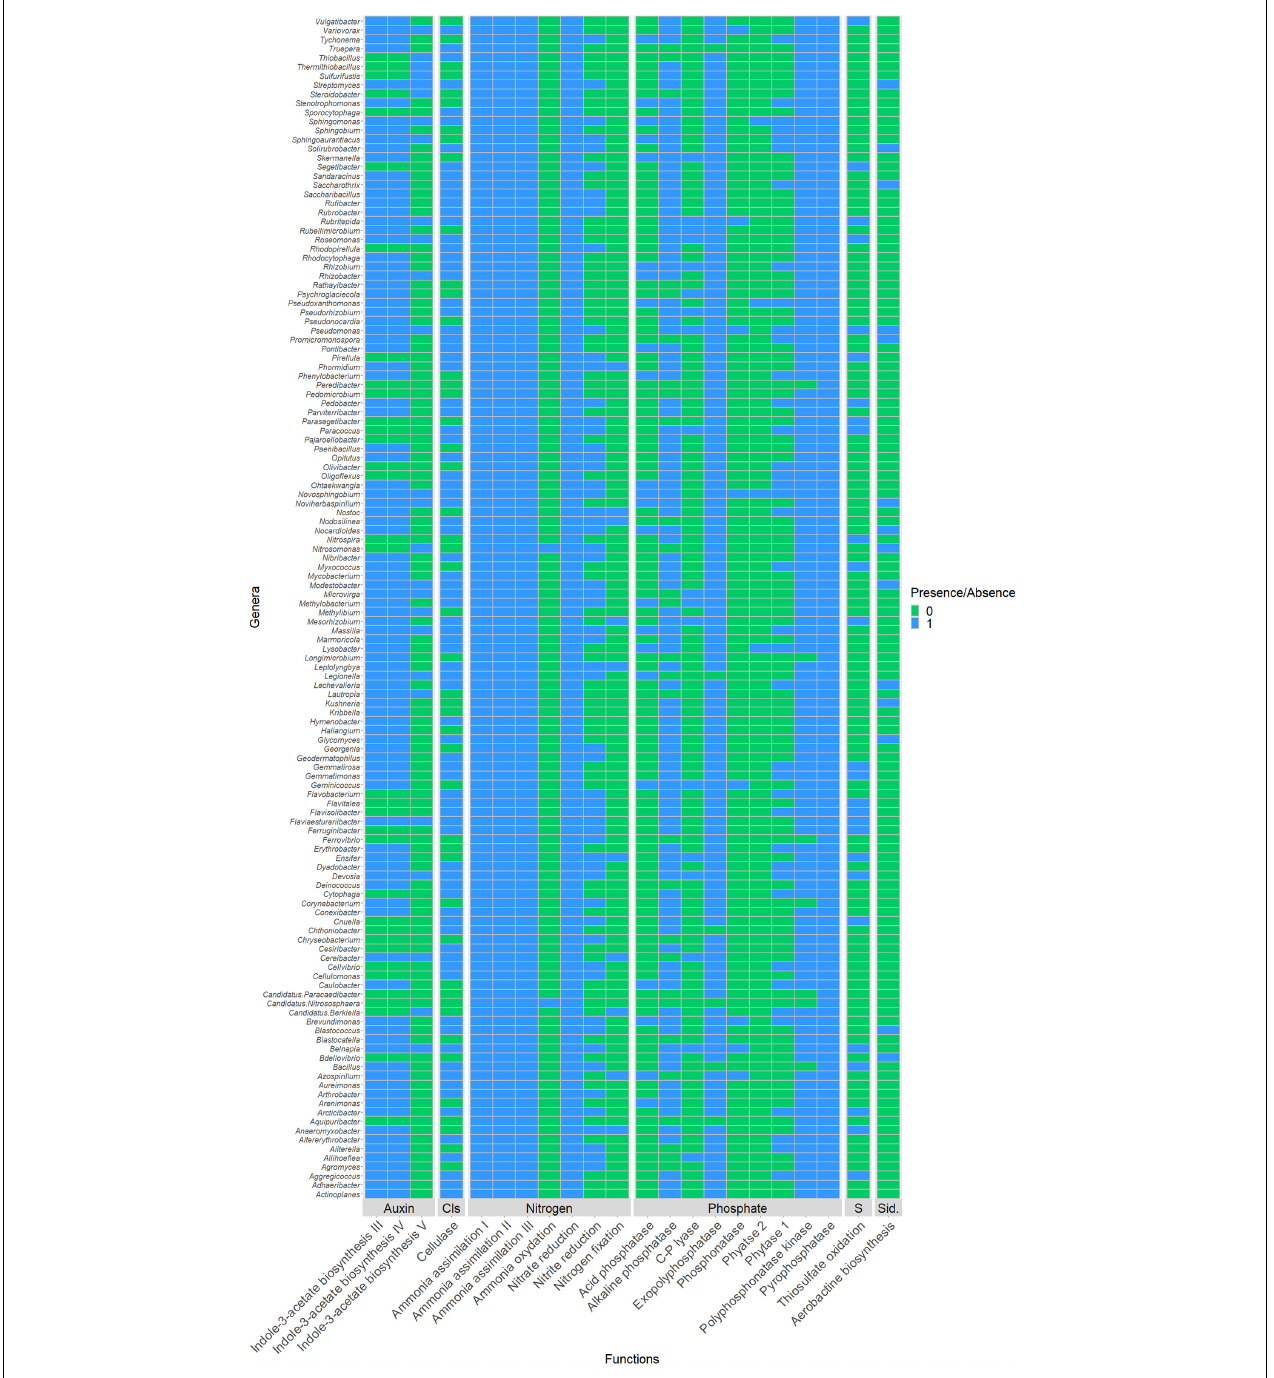
FIGURE 7 | Binary heatmap highlighting presence ( ) absence ( ) of the interested enzymes in identified genera. Enzymes implicated in: cellulose degradation by producing the cellulase enzyme (EC:3.2.1.4); sulfur metabolism by oxidizing thiosulfate (EC:1.8.2.2); siderophores production by catalyzing aerobactin biosynthesis pathway (EC:1.14.13.59, EC:2.3.1.102, EC:6.3.2.38 and EC:6.3.2.39); phosphate solubilization by producing either one or multiple of the enzymes C-P lyases (EC:4.7.1.1), phytase 1 (EC:3.1.3.8), phytase 2 (EC:3.1.3.26), alkaline phosphatase (EC:3.1.3.1), acid phosphatase (EC:3.1.3.2), and phosphonatase (EC:3.11.1.1); nitrogen metabolism by catalyzing at least one of the following pathways: nitrogen fixation I (ferredoxin) (EC:1.18.6.1), ammonia assimilation cycle I (EC:6.3.1.2 and EC:1.4.1.14); ammonia assimilation cycle II (EC:6.3.1.2 and EC:1.4.7.1), ammonia assimilation cycle III (EC:6.3.1.2 and EC:1.4.1.13), ammonia oxidation I and IV nitrite producing (EC:1.14.99.39 and EC:1.7.2.6), nitrate reduction VI L -glutamine forming (EC:1.7.7.2, EC:1.7.7.1, and EC:6.3.1.2), and nitrate reduction VI L -glutamate forming (EC:1.7.7.2, EC:1.7.7.1, and EC:1.4.1.4), and finally in auxin biosynthesis by producing enzymes implicated in indole-3-acetate biosynthesis III (EC:1.13.12.3 and EC:3.5.1.4, or in indole-3-acetate biosynthesis IV (EC:4.2.1.84 and EC:3.5.1.4) or in indole-3-acetate biosynthesis V